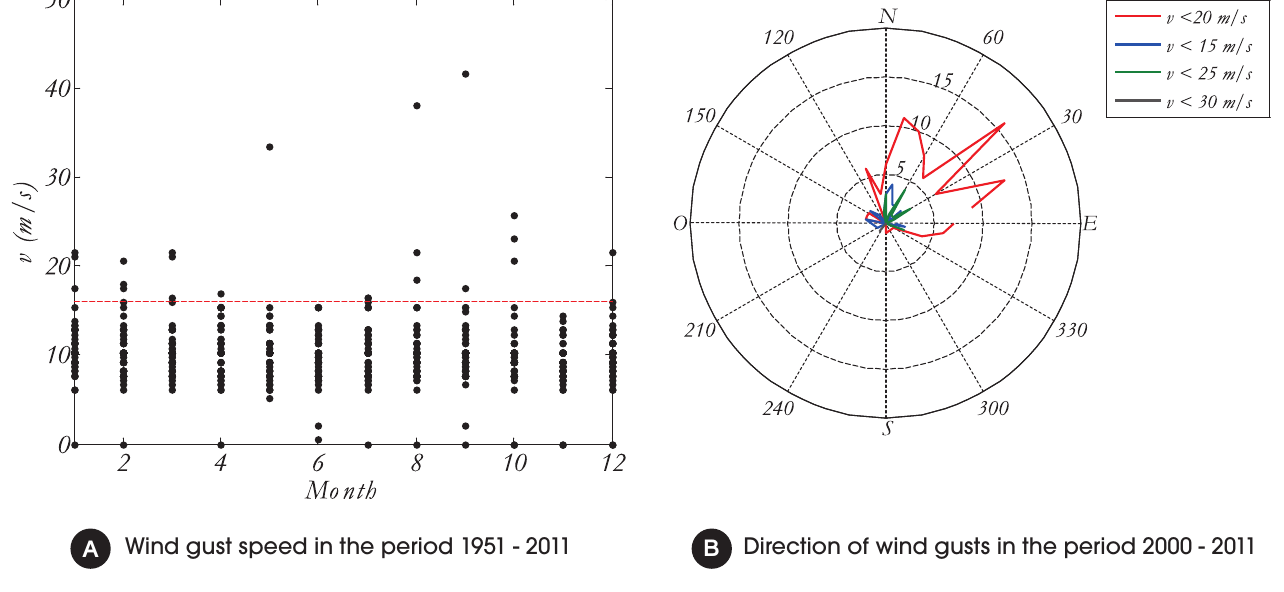
A Wind gust speed in the period 1951 - 2011 B Direction of wind gusts in the period 2000 - Figure 11 Characterization of wind gust velocity in Belem city (ICEA)